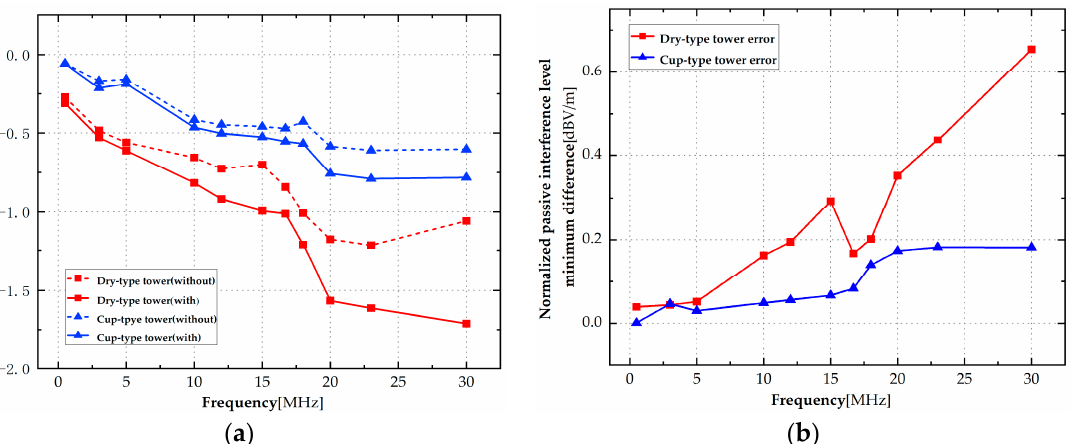
Figure 7. Comparison of influence of the tower type and auxiliary angle-steel on passive interference results under different frequency incident waves. ( a ) Change of passive interference result; ( b ) Result of error varying with frequency.